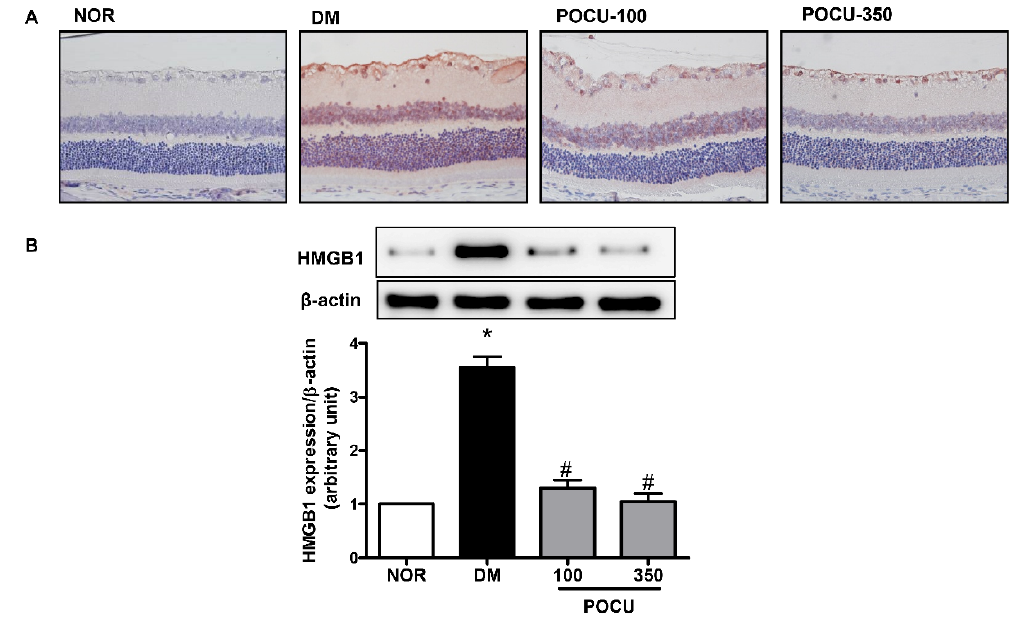
Figure 2. The effect of PCE on HMGB1 expression in the retina. ( A ) HMGB1 staining in the retina; ( B ) Western blot analysis of HMGB1 expression in a cytosolic extract of retinal tissue obtained from each group. Representative histological sections from a normal rat (NOR), an STZ ‐ induced diabetic rat (DM), a DM treated with 100 mg/kg PCE (PCE ‐ 100), and a DM treated with 350 mg/kg PCE (PCE ‐ 350). The nuclei were counterstained using hematoxylin ( blue ). Original magnifications: ×400.